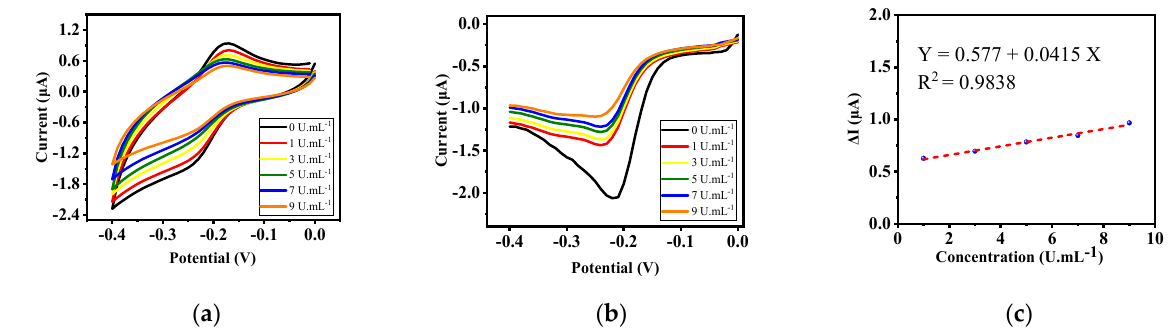
Figure 6. ( a ) CV and ( b ) SWV test results at various concentrations of CA 15-3 with the labeled electrode by methylene blue.